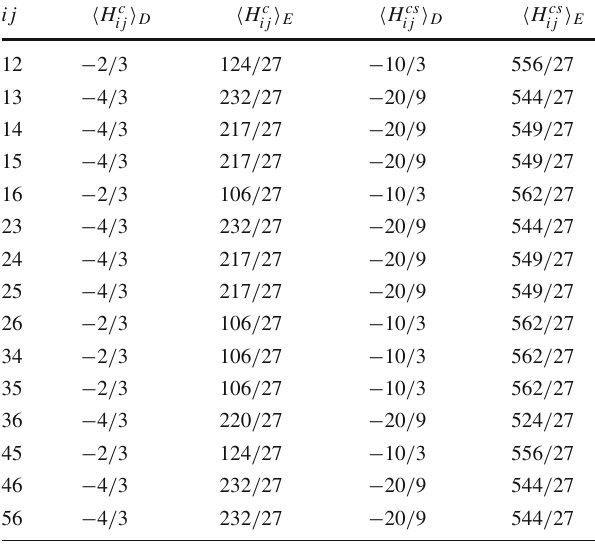
Table 11 The matrix elements in spin-flavor-color-isospin spaces of the hidden-color channel for the Ω ccb Ω bbc system with J P = 0 +